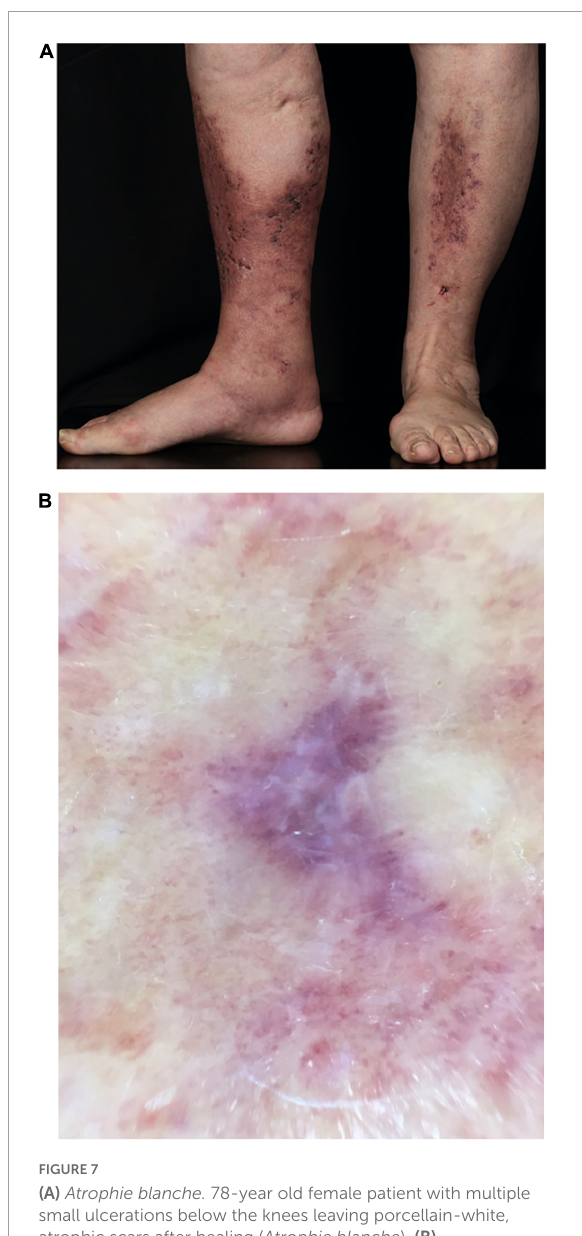
FIGURE7 (A) Atrophie blanche. 78-year old female patient with multiple small ulcerations below the knees leaving porcellain-white, atrophic scars after healing ( Atrophie blanche ). (B) Dermatoscopy of LV. Ivory white scar-like areas in the center and hyperpigmentation in the periphery of the